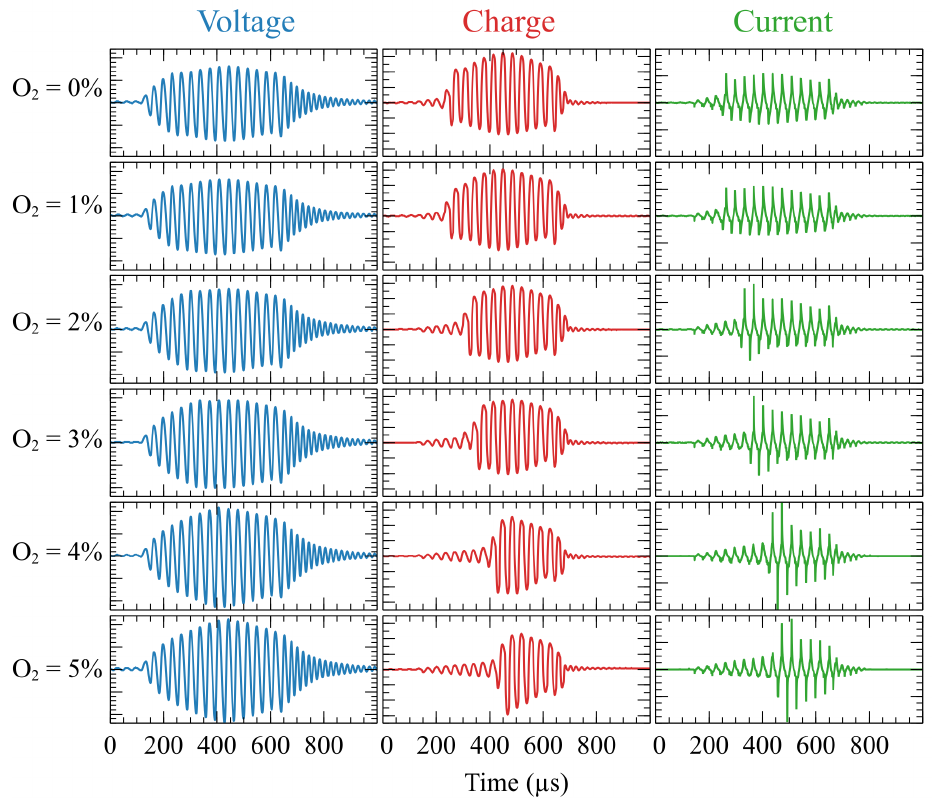
Figure 3. Waveforms of applied voltage, capacitor charge and current for various concentrations of additional O 2 . The He flow rate was 1.5 L/min and the distance d was 7 mm. Vertical scales are constant for each parameter: Voltage: ± 12 kV; Charge: ± 70 nC; Current: ± 40